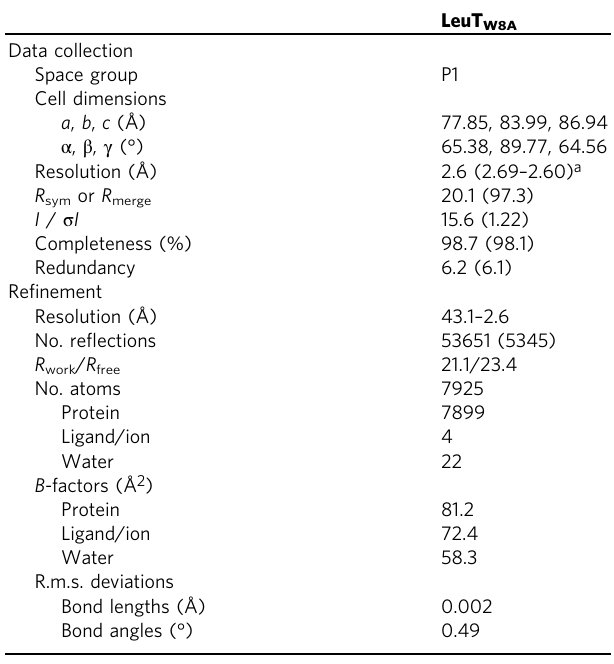
Table 1 Data collection and re fi nement statistics (molecular